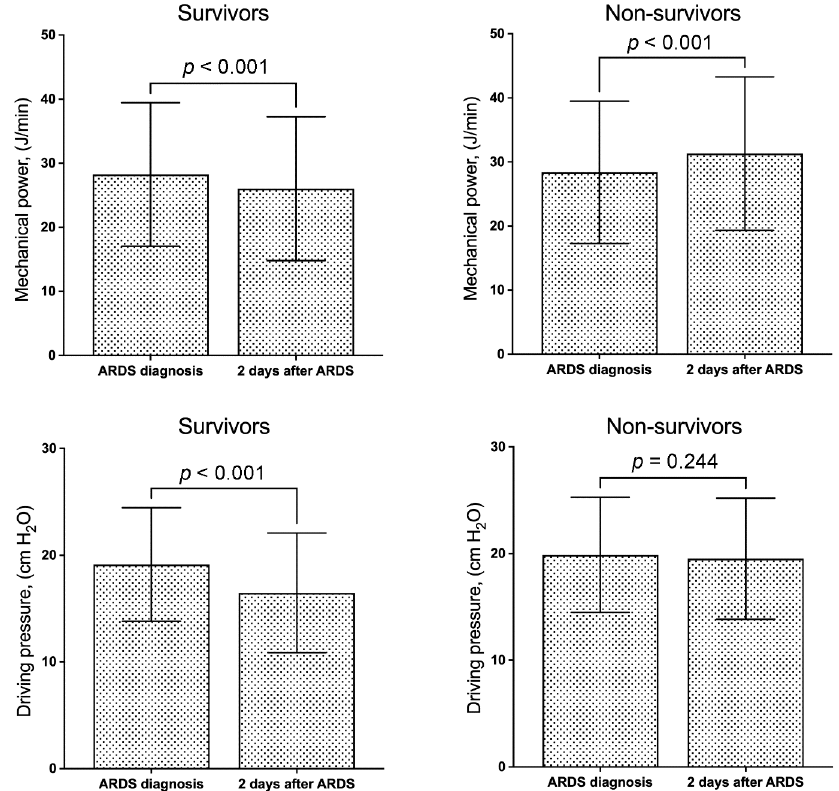
Figure 2. Column chart of mechanical power and driving pressure (mean ± 1 standard deviation) between survivors and non-survivors on the day of acute respiratory distress syndrome (ARDS) diagnosis and 2 days after ARDS diagnosis. Table 2. Binary logistic regression to analyze the independent factors associated with 30-day mor- tality.